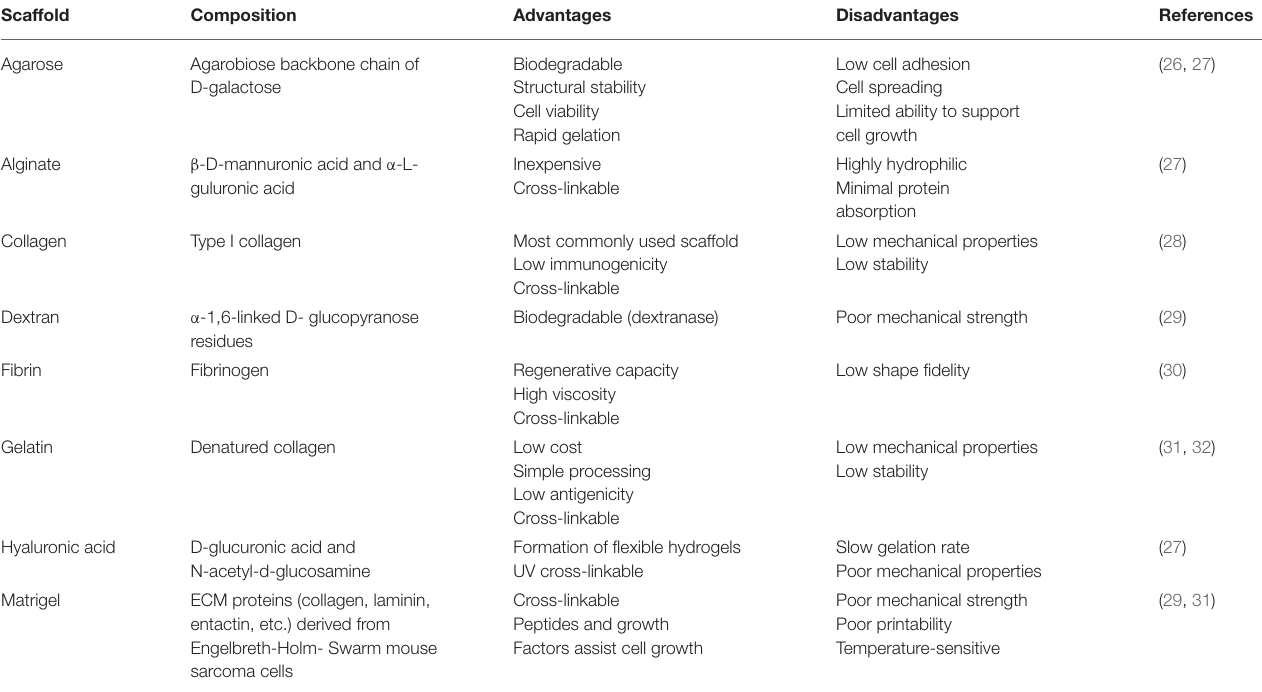
TABLE 2 | Properties of common biological